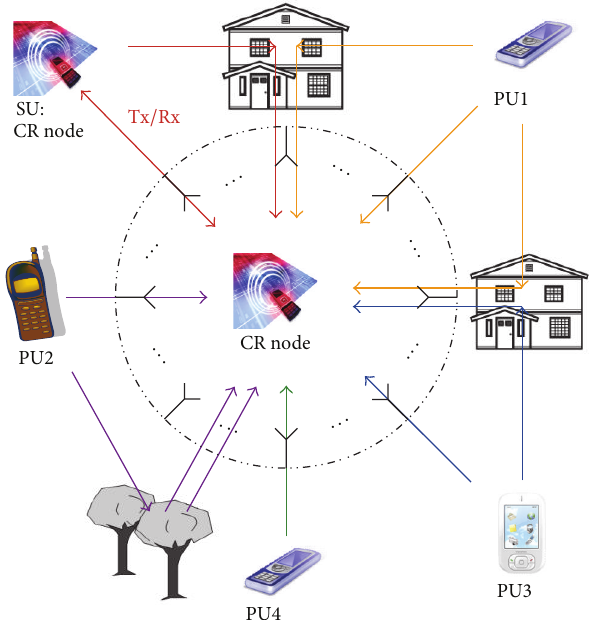
Figure 8: A typical multipath environment to be emulated for the evaluation of CR devices in OTA in VEE closed-loop test-bed